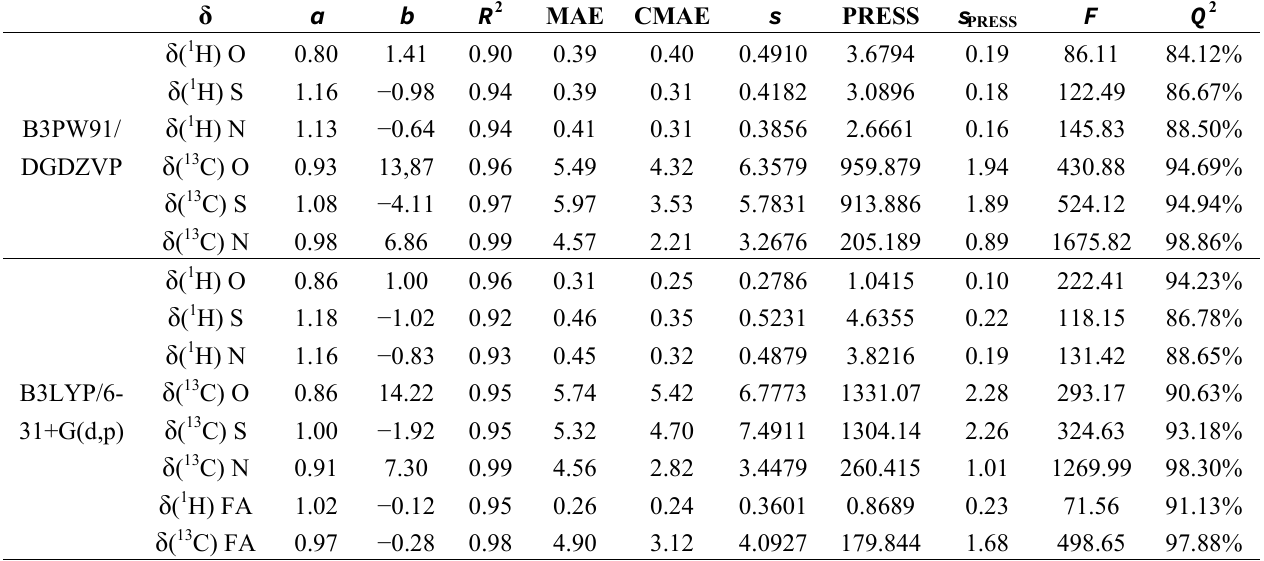
Table 4. Correlation and linear adjustment parameters for the NMR properties of the O , S and N structures and ferulic acid